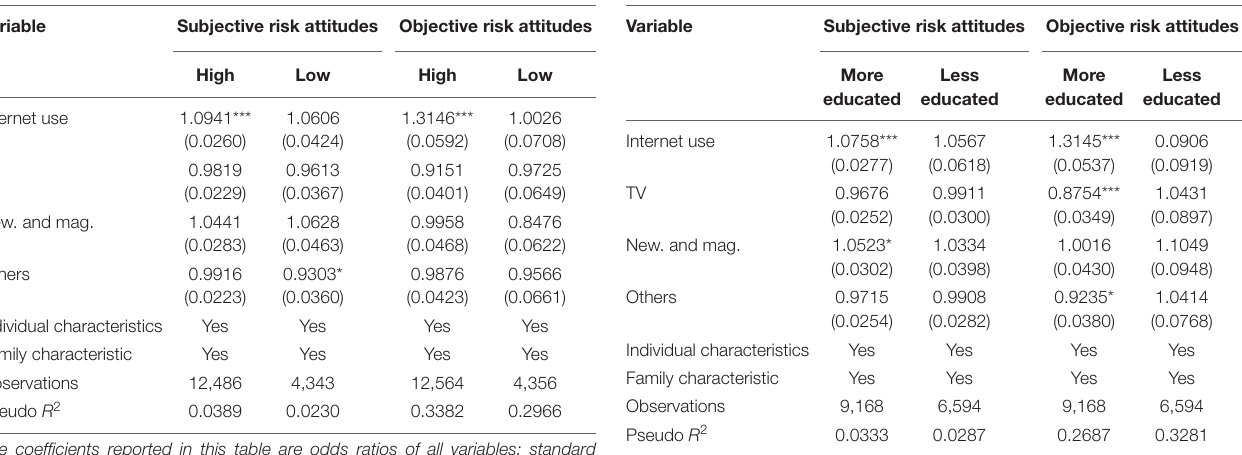
TABLE 7 | Grouped by the using frequency for commerce.